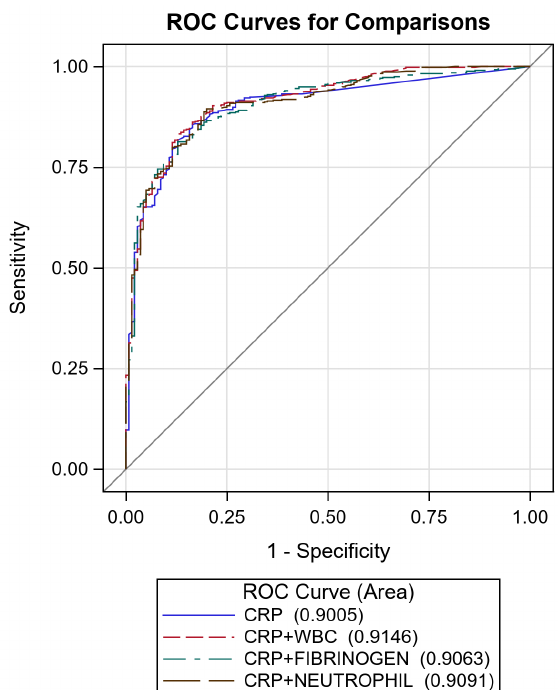
Table 5. Biomarkers’ cut-offs with corresponding sensitivity and specificity. Cut-offs were obtained maximizing the percentage of correctly classified cases.